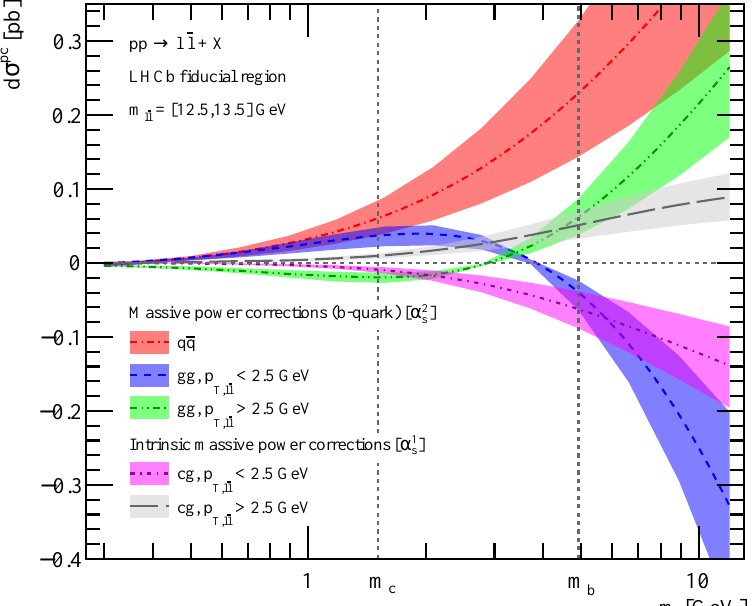
Figure 3: Massive power-corrections to the DY cross-section within the LHCb fiducial region with m (cid:96) ¯ (cid:96) ∈ [ 12.5,13.5 ] GeV. The partonic-channels, perturbative orders, and considered p regions (unless inclusive) are highlighted. The scale uncertainty of T, (cid:96) ¯ (cid:96) each of these predictions is